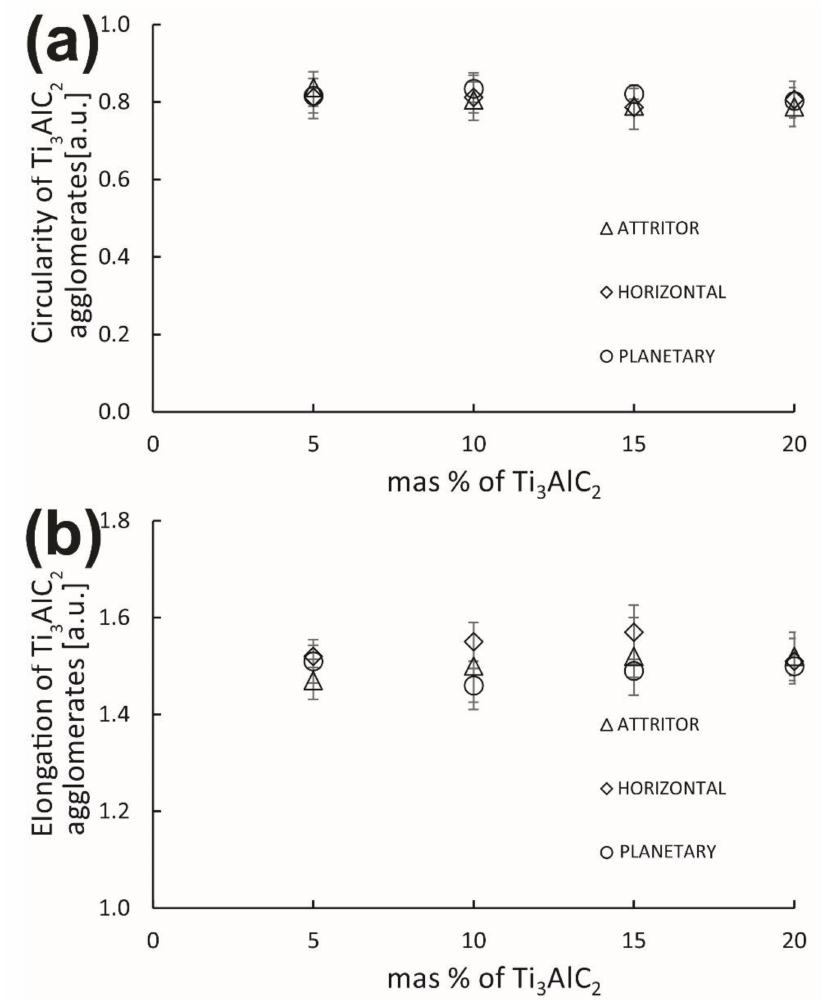
Figure 9. The ( a ) circularity and ( b ) elongation of Ti 3 AlC 2 agglomerates.